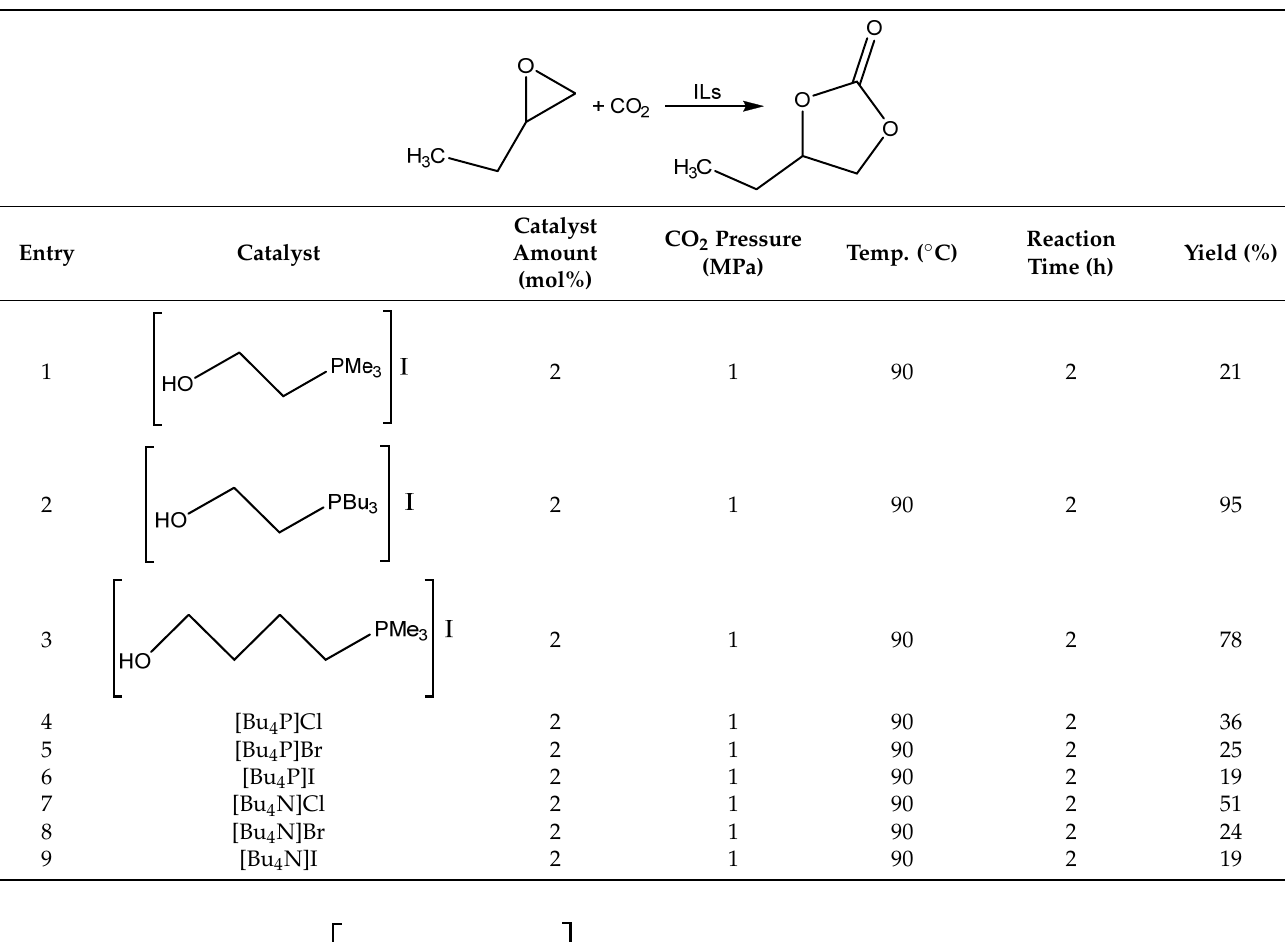
Table 23. Comparison of catalytic action of different substituted phenols on carbonation of hexylene oxide [94].